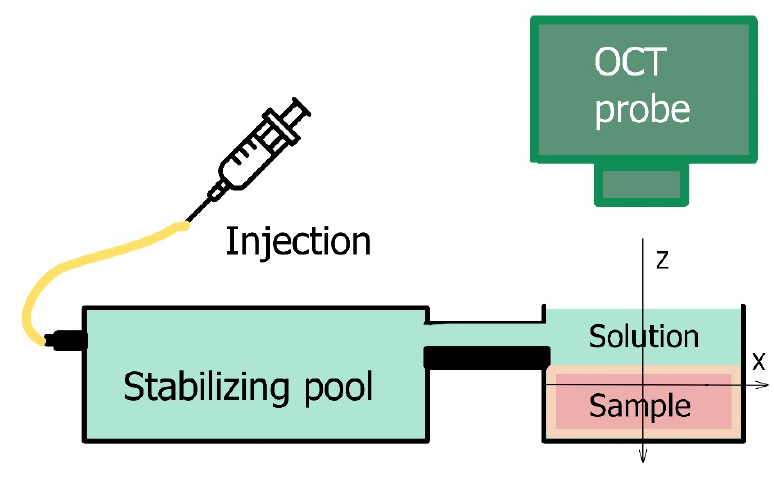
Figure 1. Experimental set up for osmotically-induced strain monitoring.